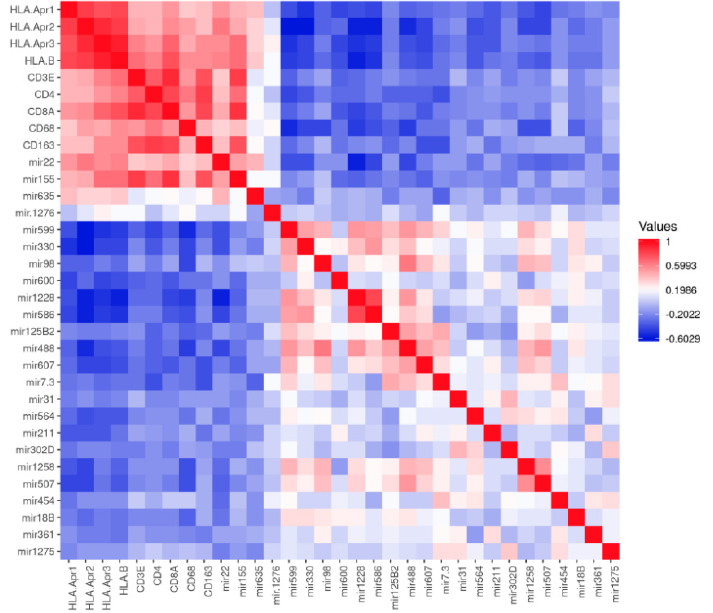
Figure 3. Expression of miRNAs was compared to the mRNA expression of HLA Class I and markers of infiltrate. Relation between miRNAs and mRNA levels from 64 Uveal melanoma are shown in a pairwise correlation matrix. Red indicates a positive correlation, blue a negative correlation.